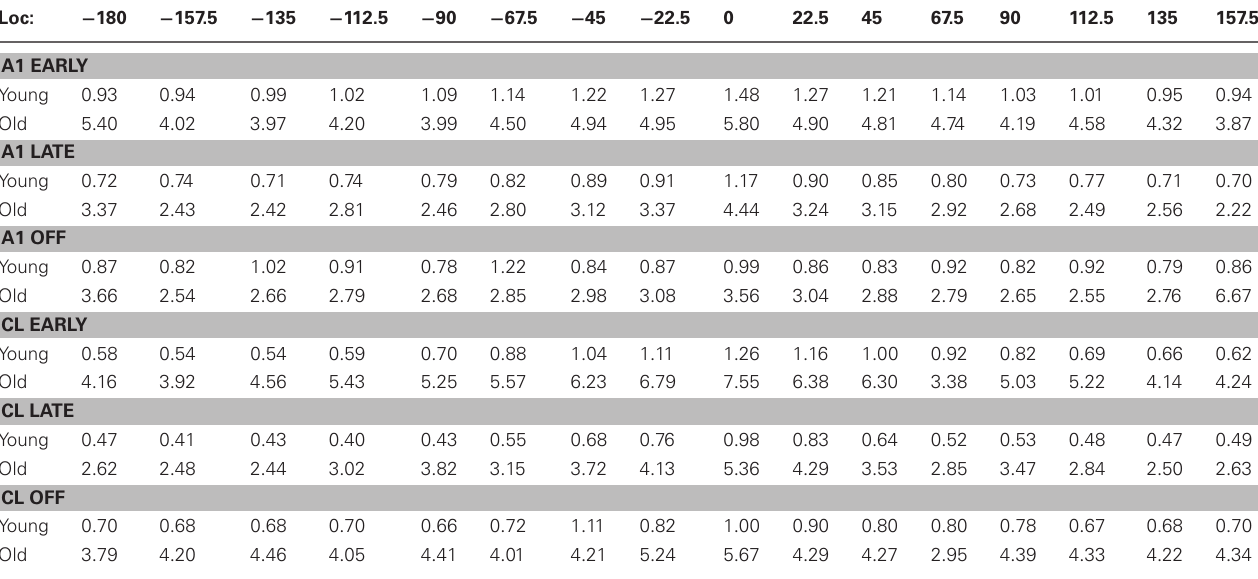
Table 2 | Standard errors of the mean for firing rates as a function of stimulus location (see Figure 4 for the mean